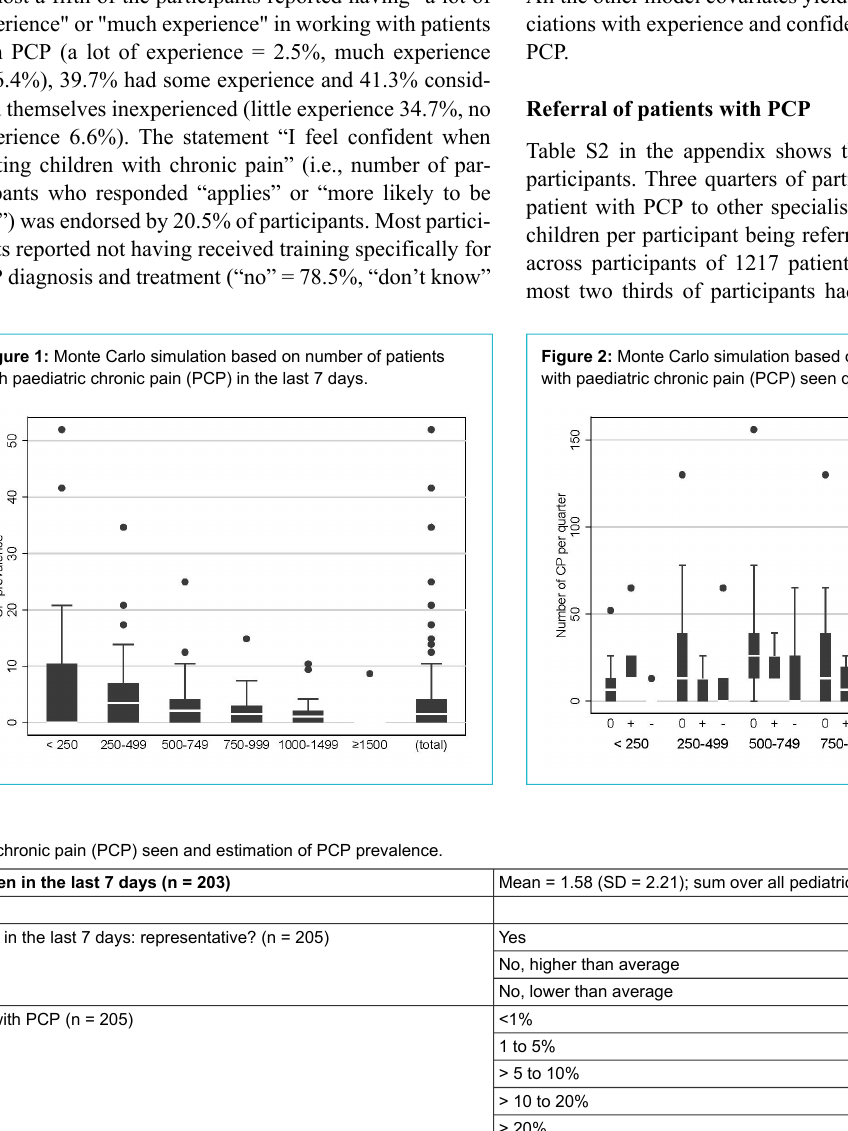
Estimated prevalence of patients with PCP (n =